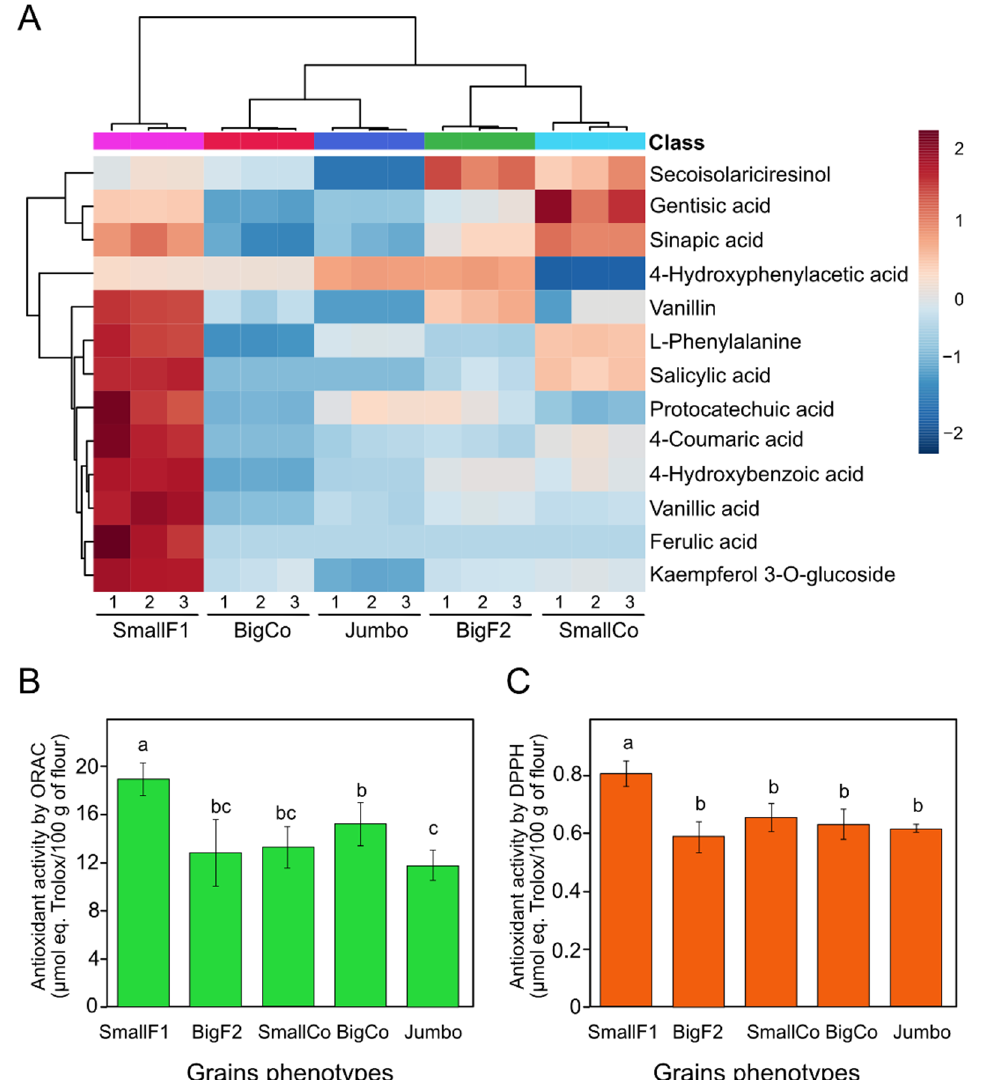
Figure 5. Confirmation of antioxidant capacity of small chickpea genotype. Heatmap of the 13 phenolic compounds identified and quantified in chickpea grains by targeted analysis. At the top is shown the clustering result by using the Euclidean distance and Ward algorithm in the MetaboAnalyst bioinformatic platform. Each colored cell on the map corresponds to an autoscaled concentration value (Table S5, ( A )). Total antioxidant capacity of chickpea grain flour by oxygen radical absorbance capacity (ORAC; ( B )) and 2-diphenyl-1-picrylhydrazyl (DPPH; ( C )). We showed average values and the corresponding standard deviation. Different letters indicate statistical differences between samples. Data were calculated based on dry weight content.